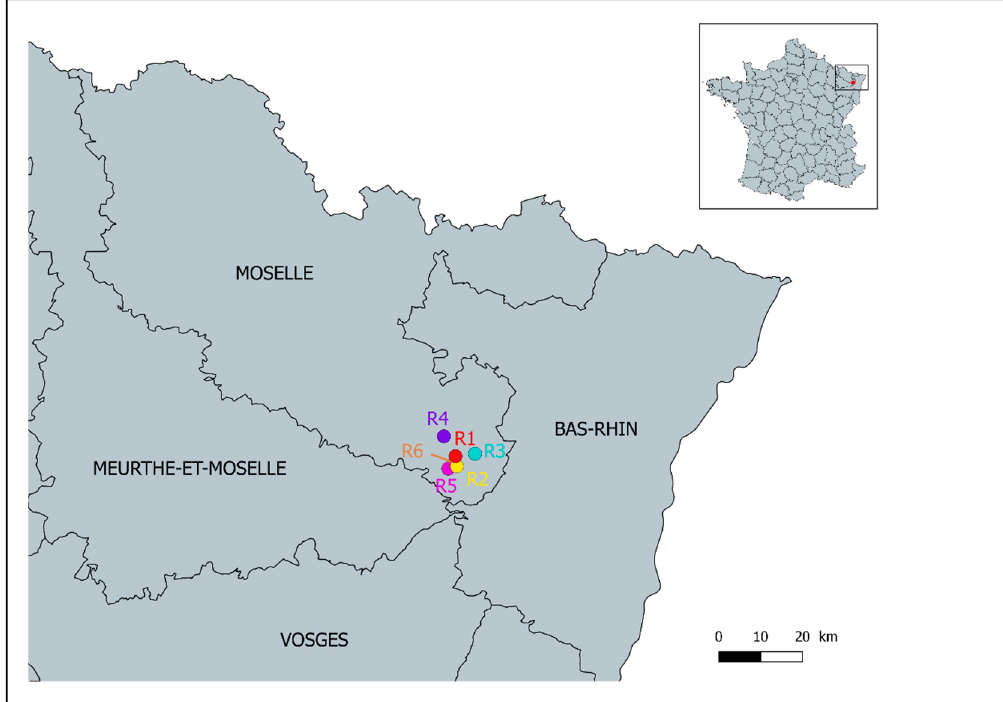
Figure 1. Localization of the orienteering competition. R1 to R6 correspond to racing rounds 1 to 6. R6 took place very close to R5 and cannot be displayed on the map.